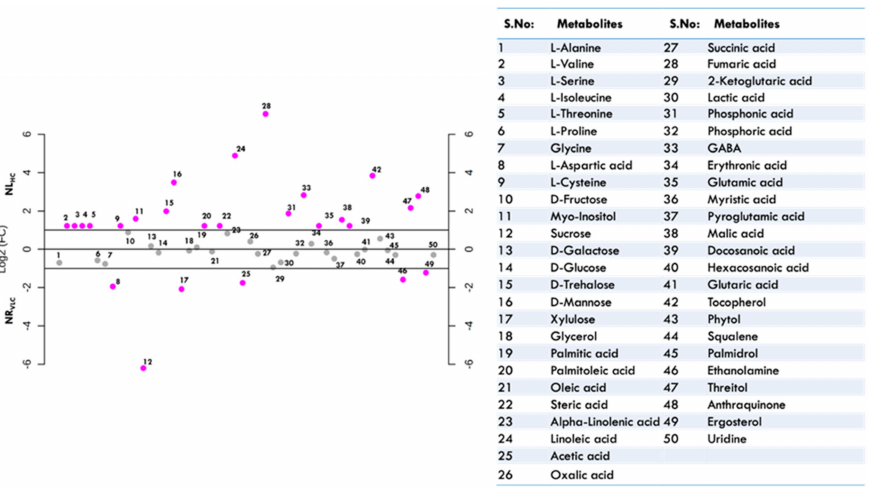
Figure 5. Dot-plot representing metabolites upregulated and downregulated in the native isolate Monoraphidium sp. CABeR41 subjected to NR VLC vs. NL HC conditions on the 8th day of cultivation with a summary of table representing the identified metabolites (pink dots represent the metabolites that show >log 2-fold change and grey dots represents the one that show <log 2-fold